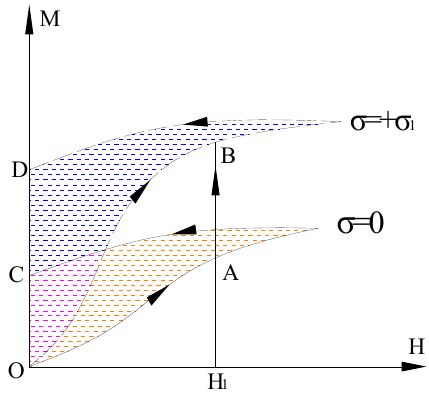
Figure 2. Schematic Diagram of a magnetization curve under tensile stress.